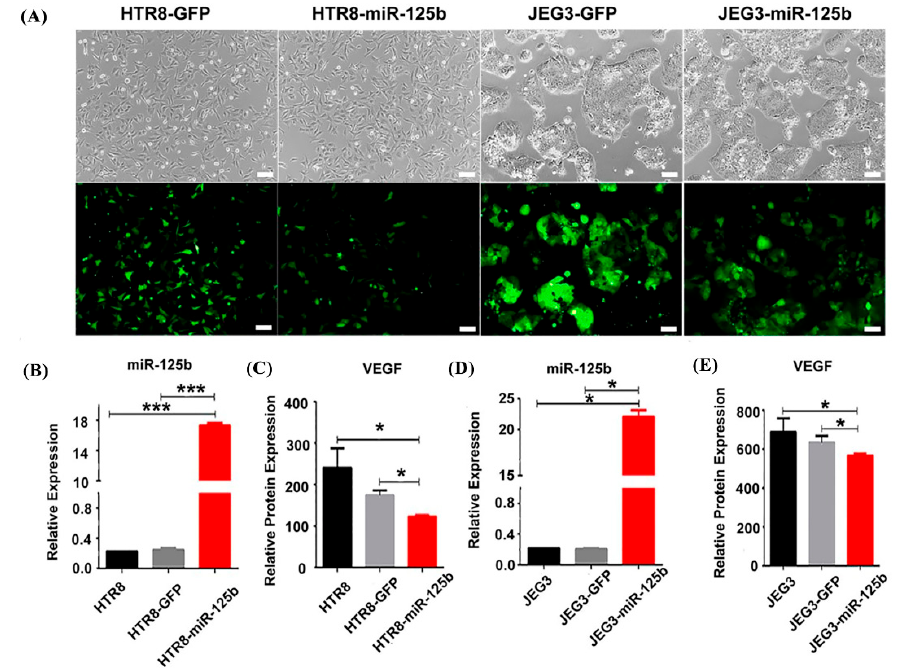
Figure 5. Establishment of HTR8 and JEG3 cell lines that can express miR-125b and regulate the expression of VEGF ( A ): HTR8 and JEG3 cell lines that express GFP (HTR8-GFP, JEG3-GFP) and miR125b (HTR8-miR125b, JEG3-miR125b); images as observed under the microscope 10 times; ( B ) and ( D ): the expression of miR-125b in HTR8 and JEG3 cell lines by RT-qPCR. Data are presented as mean ± SEM, n = 3 (* p < 0.05; *** p < 0.01); ( C , E ): the protein expression of VEGF in HTR8 and JEG3 cell lines by ELISA. Data were presented as mean ± SEM, n = 3 (* p < 0.05).